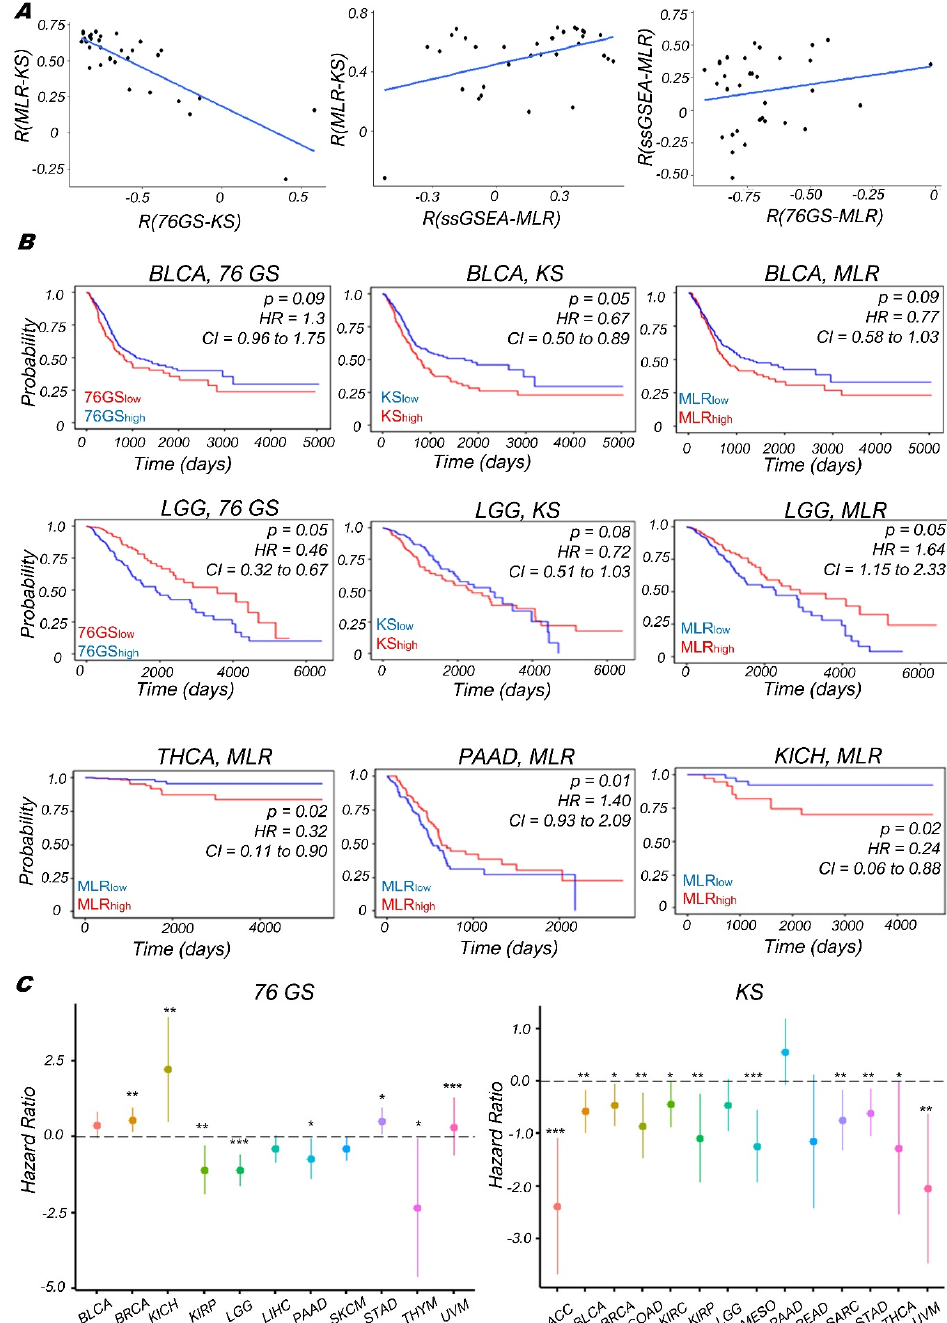
Figure 5. EMT scoring in TCGA datasets and survival analysis using patient samples. ( A ) Scatter plot of pairwise correlation estimated using linear regression (blue) in TCGA datasets. ( B ) Correlation between EMT score (high vs. low) and overall survival (OS) in various TCGA datasets. Kaplan– Meier survival analysis is performed to estimate differences in survival for different EMT metrics. p -values ( p ) reported are based on log rank test. The values of Hazard ratio (HR) with 95% confidence interval (CI) values are included. ( C ) Plot of log2 hazard ratio (HR; mean ± 95% confidence interval) comparing overall survival (OS) of 76GS (left) and KS (right) EMT scoring metrics on different TCGA cancers and cohorts. p -values are based on log-rank test, and those with significant differences ( p < 0.05) are marked with a star (*); **: p < 0.01; ***: p <